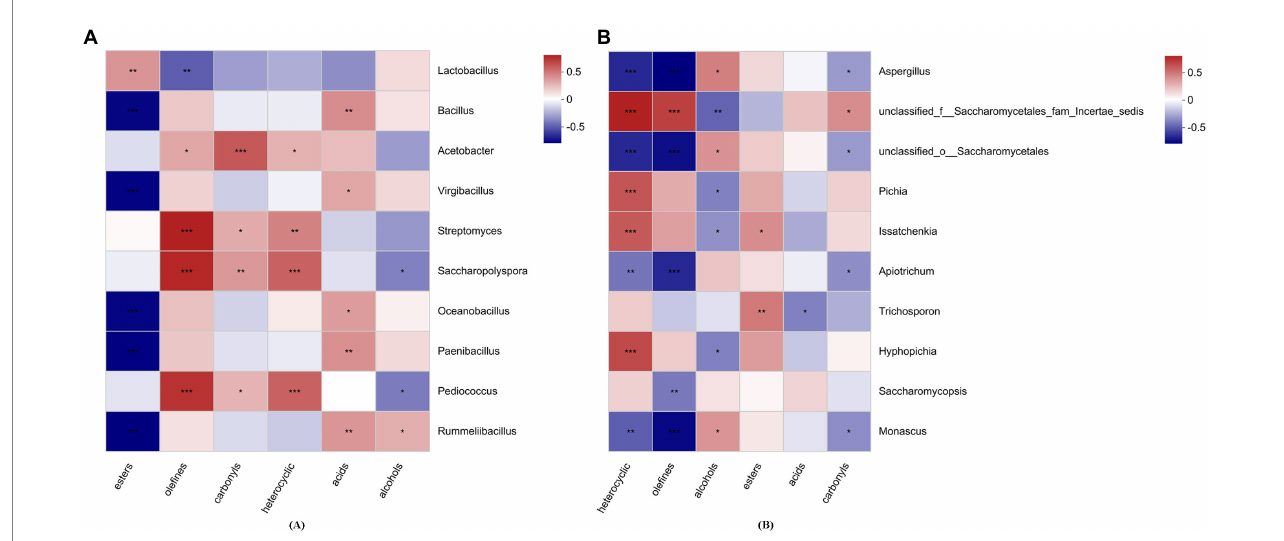
FIGURE 7 The correlation between volatile flavor compounds and the top 10 bacterial (A) and fungal (B) genera. * p < 0.05, ** p < 0.01, *** p <